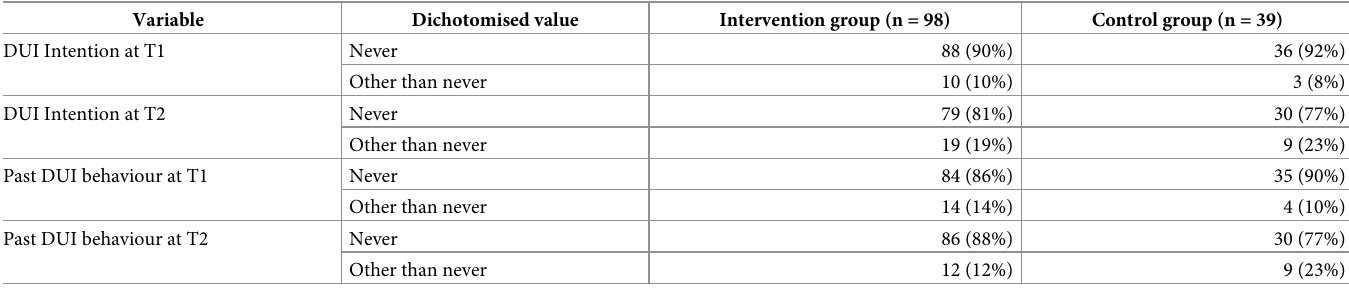
Table 2. Frequencies and percentiles per group condition (n =